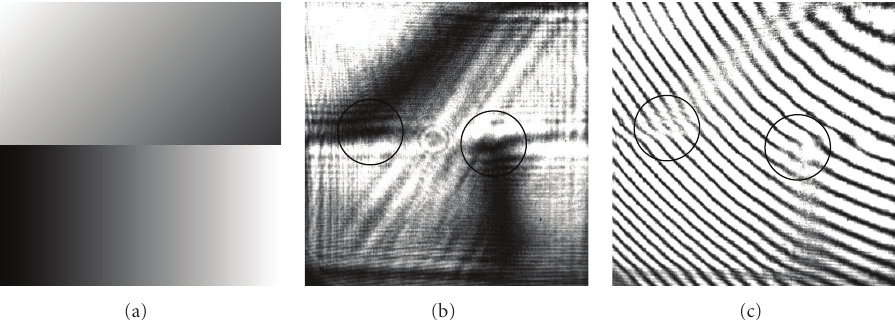
Figure 4: (a) Phase distribution for one oblique and one linear phase ramp. (b) Experimentally observed intensity distribution of propagated field when phase mask corresponding to (a) is displayed onto the SLM. (c) Formation of fork fringes when the propagated field interfers with a plane wave coming from the other arm of the Mach-Zehnder